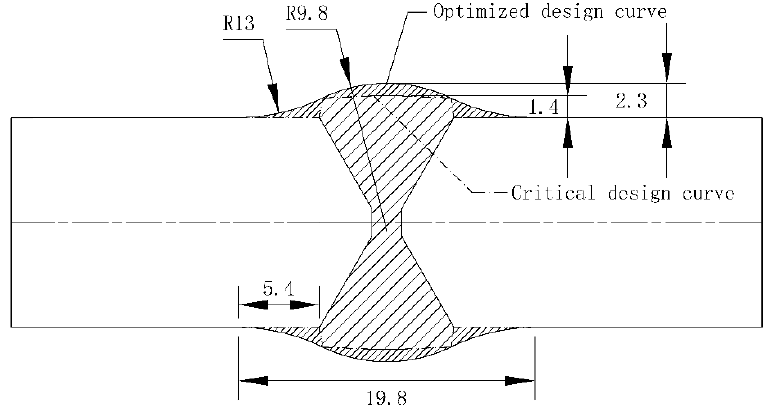
Figure 11. Geometric parameters of the designed Q550d (ER50-6) butt-welded joints.